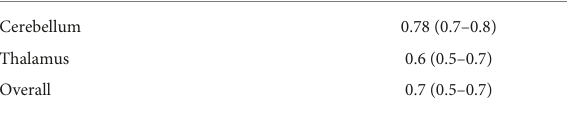
TABLE 3 Intra-reliability test – Dice similarity